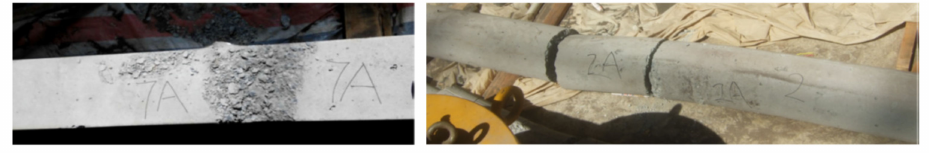
Figure 10. Columns after blast test [24]. Copyright permission obtained from authors.